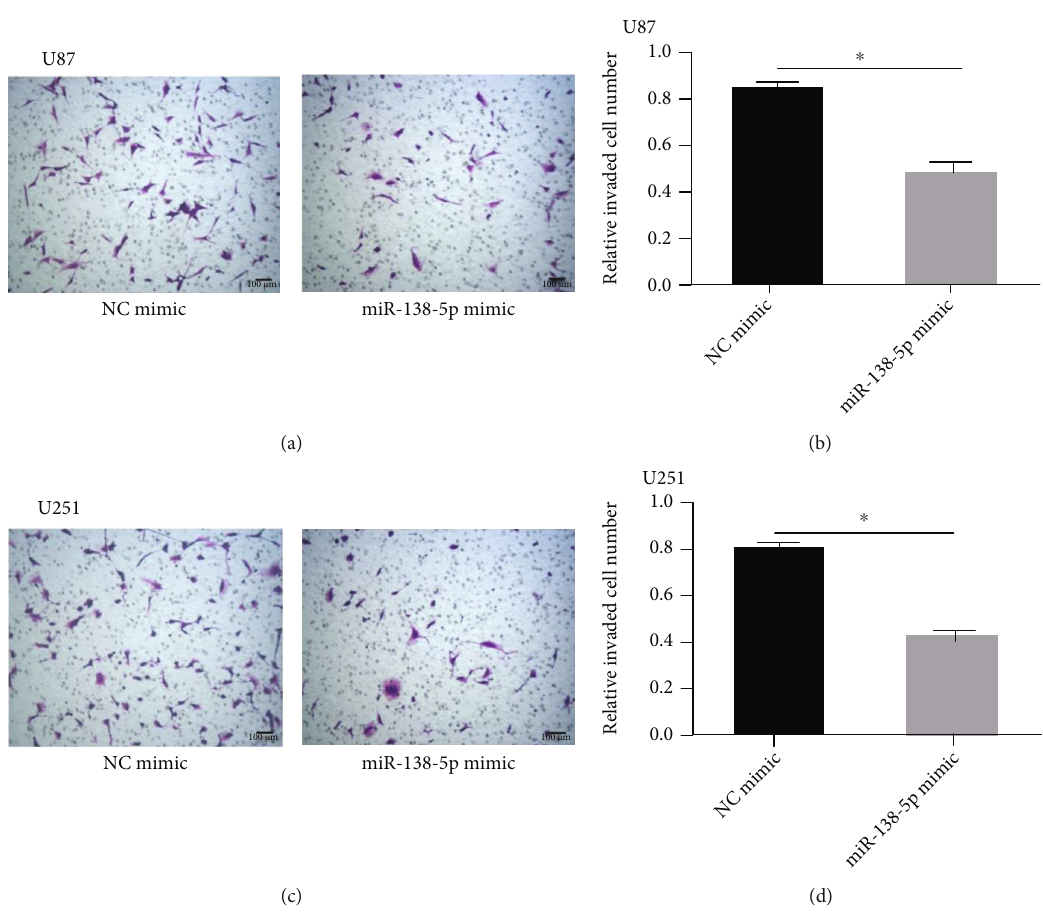
Figure 3: Overexpression of miR-138-5p inhibited the migration and invasion of U87 and U251 cells. (a – d) Transwell migration and invasion assays with U87 and U251 cells transfected with miR-138-5p mimics or NC. Each experiment was repeated at least three times. ∗ P < 0 : 05 .